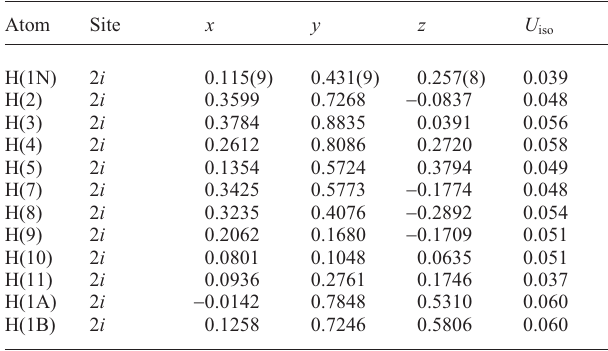
Table 2. Atomic coordinates and displacement parameters (in Å 2 )